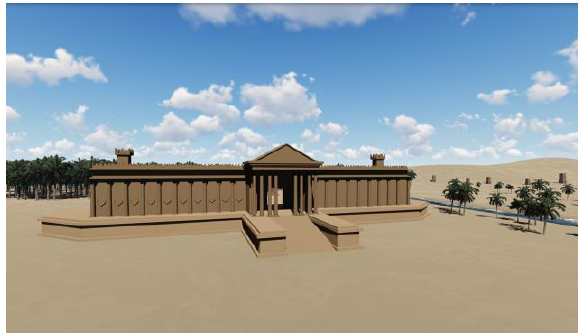
Figure 3. Triumphal arch directed the view to the entrance of the temple